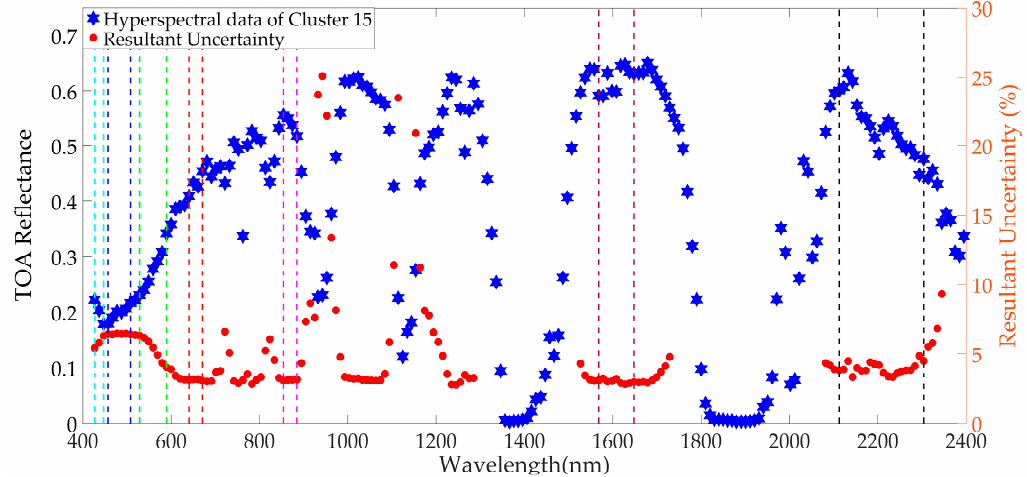
Figure A11. Estimated representative hyperspectral profile of Cluster 14 and its resultant uncertainty.